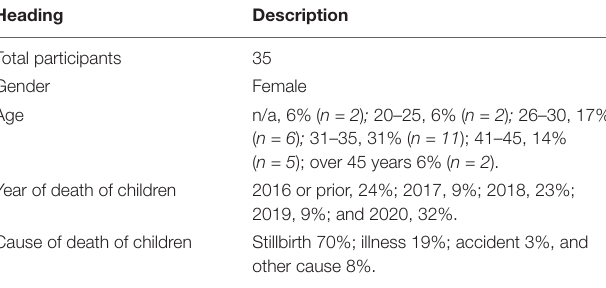
TABLE 1 | Sociodemographic information of the study participants.